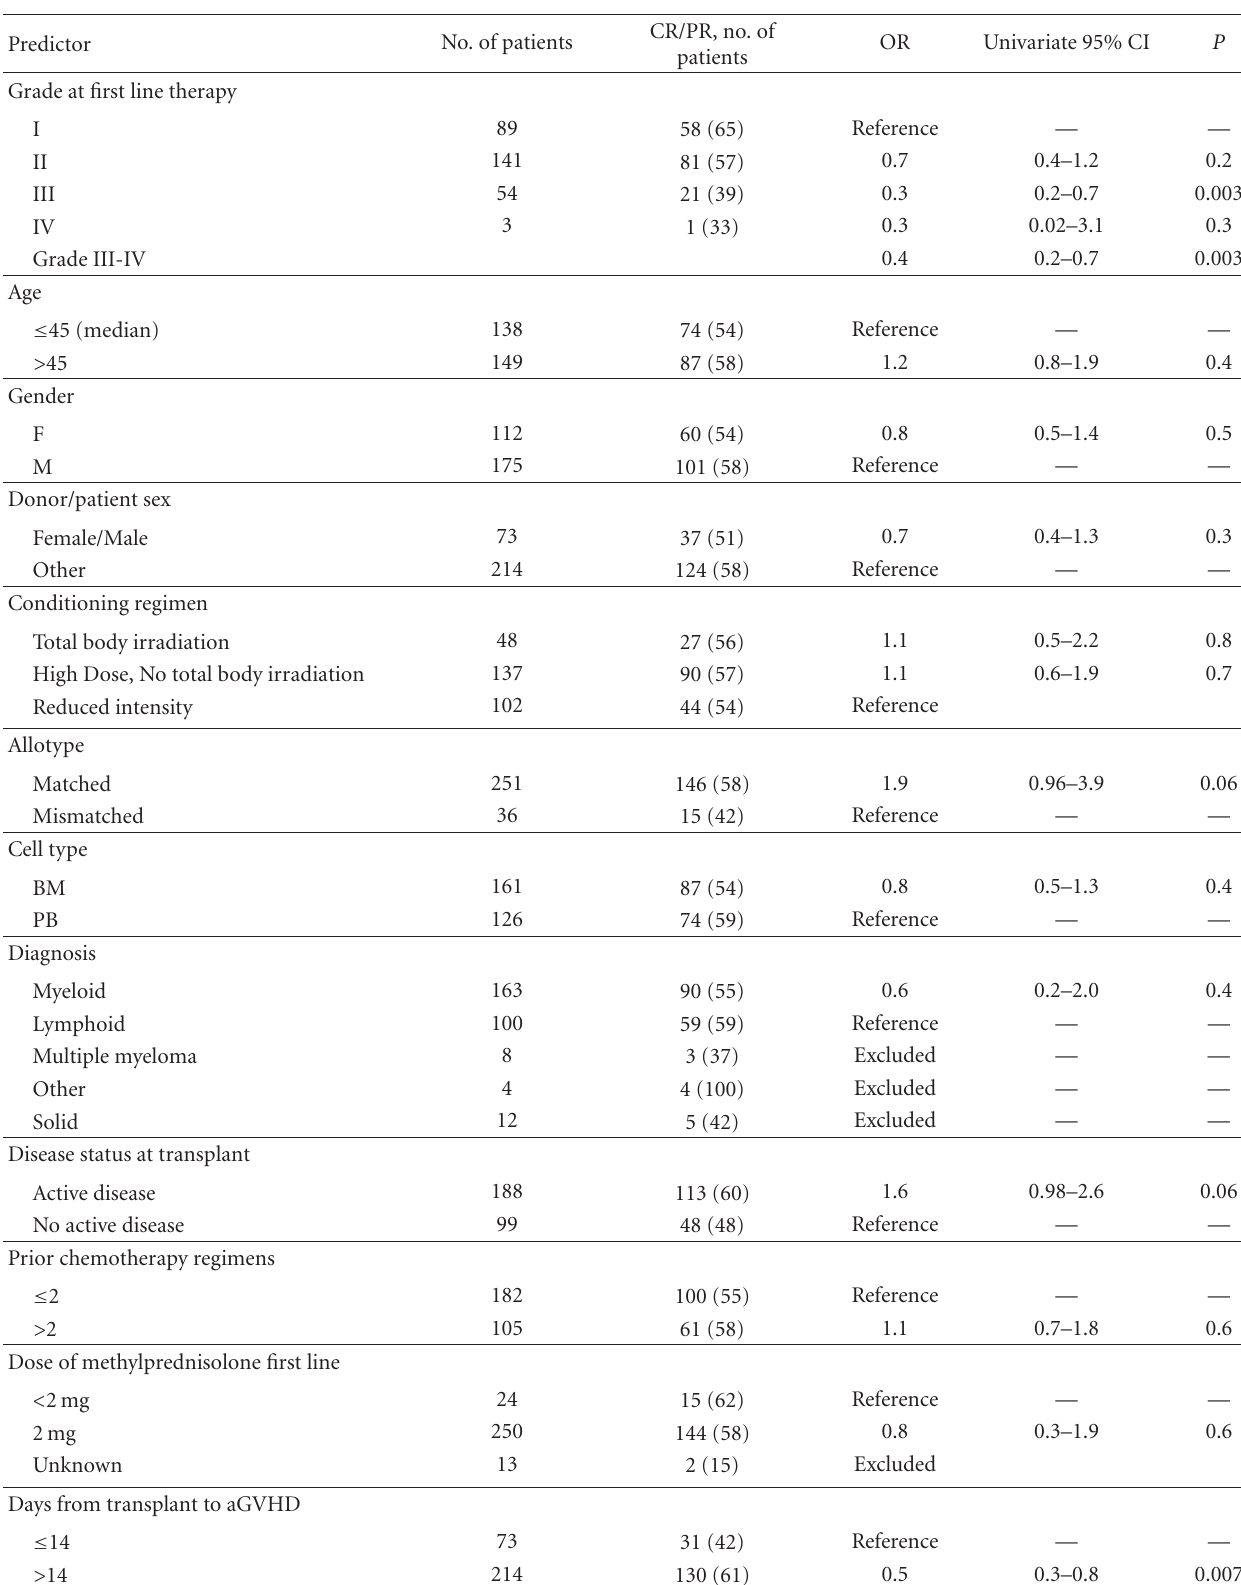
Table 2: Evaluation of predicators of first-line therapy for treatment of acute